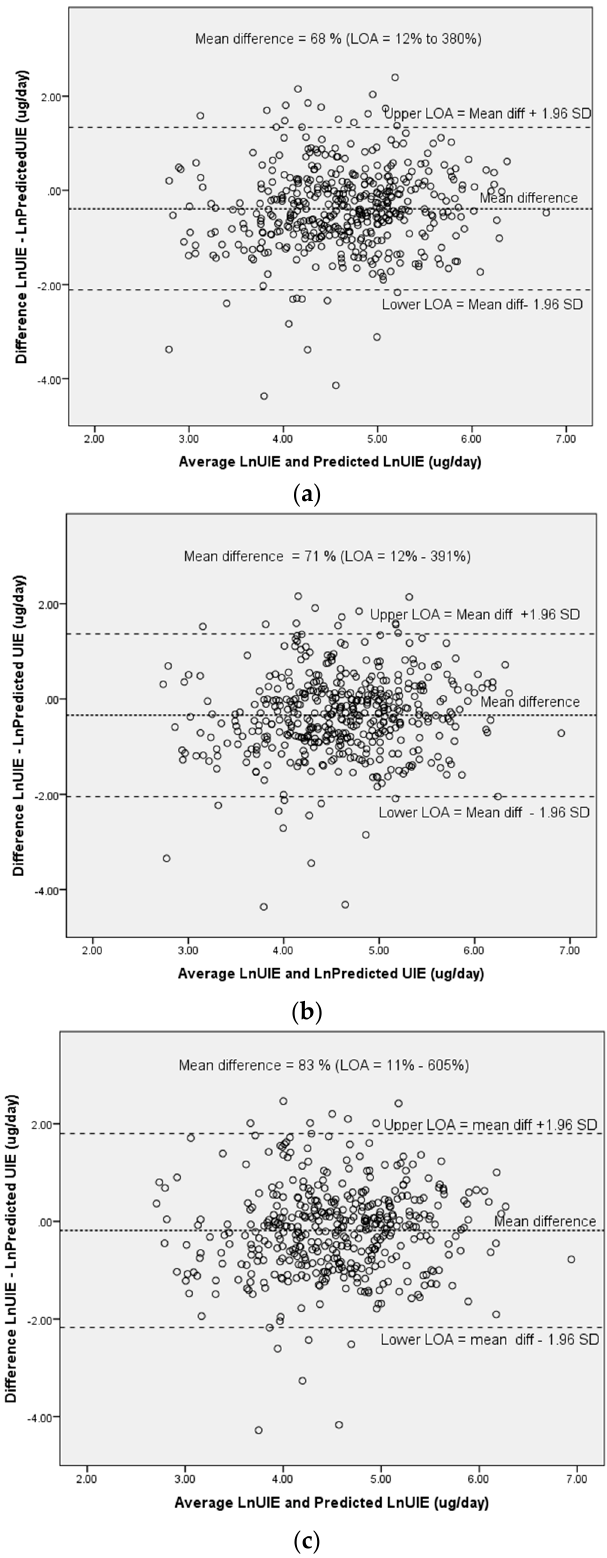
Figure 1. Bland Altman plots for the mean of natural logarithmic (Ln) transformed measured 24 h UIE and Ln transformed predicted UIE against the difference between ln transformed measured 24 h UIE and predicted UIE, using the following equations: ( a ) Tanaka; ( b ) Kawasaki; and ( c ) Mage equations; LOA = Limits of Agreement (Ln mean difference between measured and predicted UIE +/ − 1.96 SD; shown as antilog or geometric mean, expressed as a ratio of difference between predicted UIE and measured 24 h UIE).